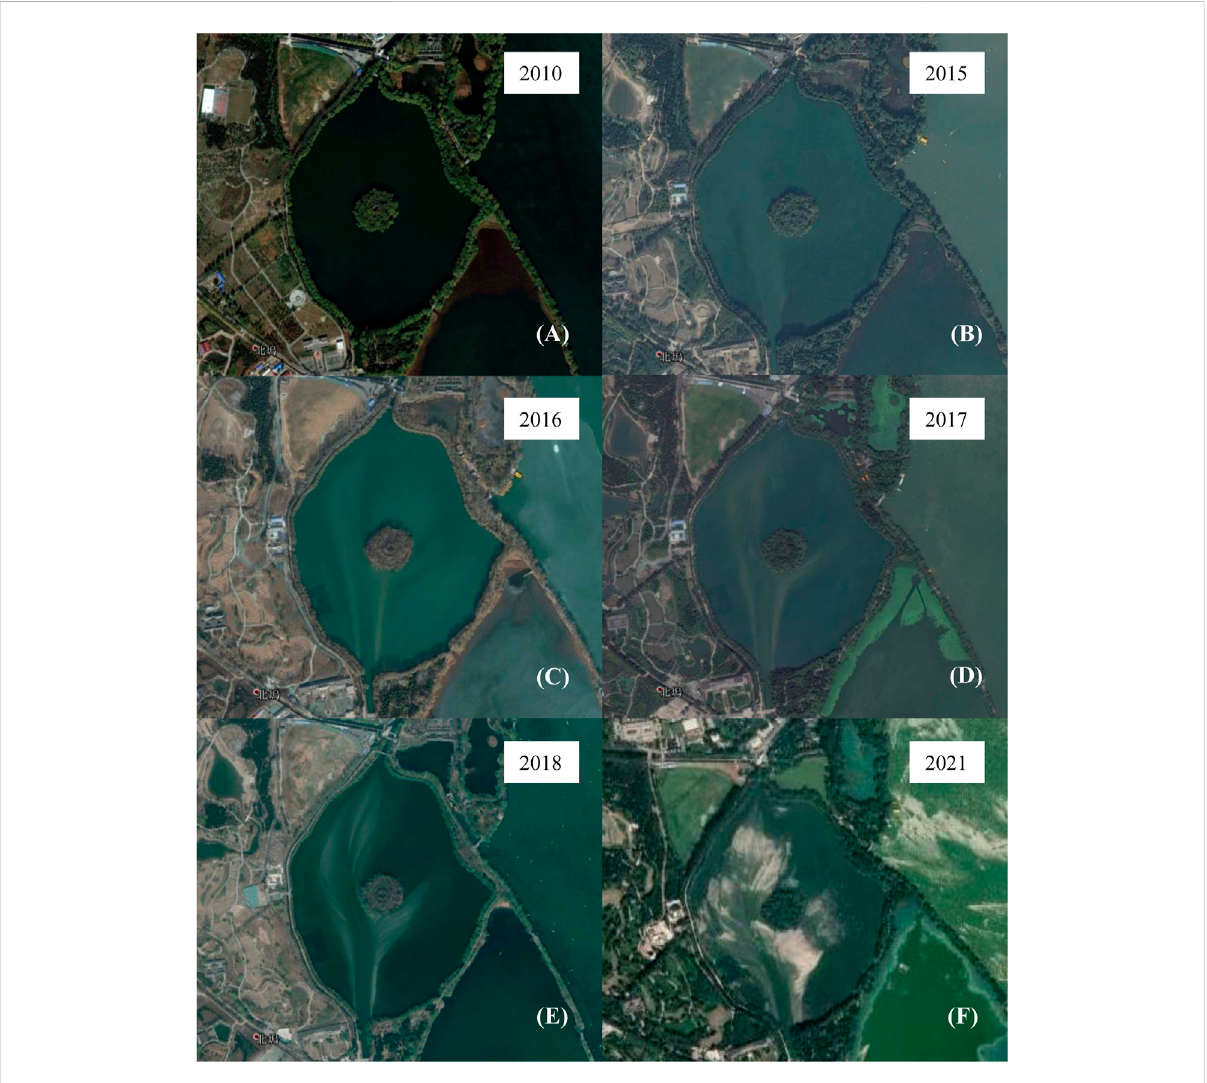
FIGURE 2 Satellite images of Tuancheng Lake from Google Earth over the past 10 years. (A) In 2010. (B) In 2015. (C) In 2016. (D) In 2017. (E) In 2018. (F) In